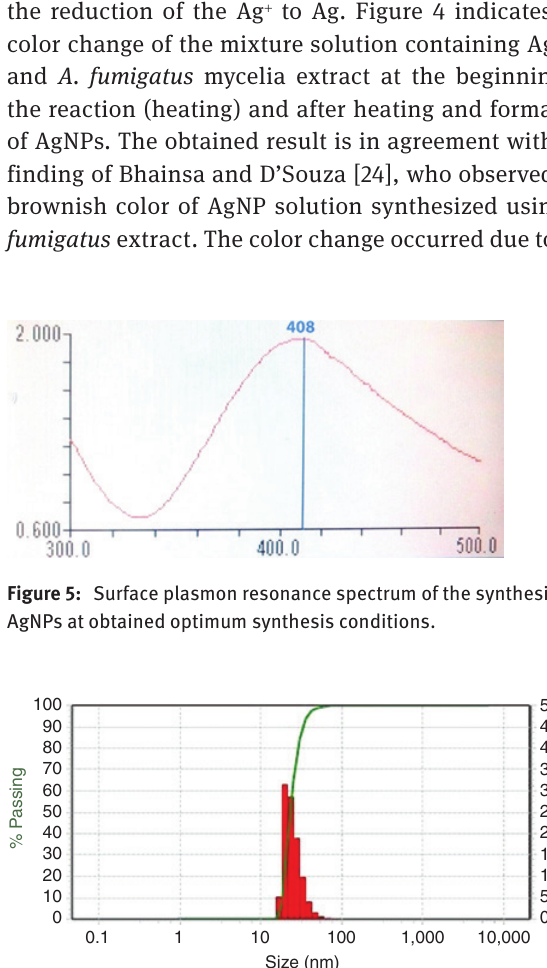
Figure 4: Color and appearance of the mixture solution containing AgNO and (B) after heating and subsequent formation of AgNPs.